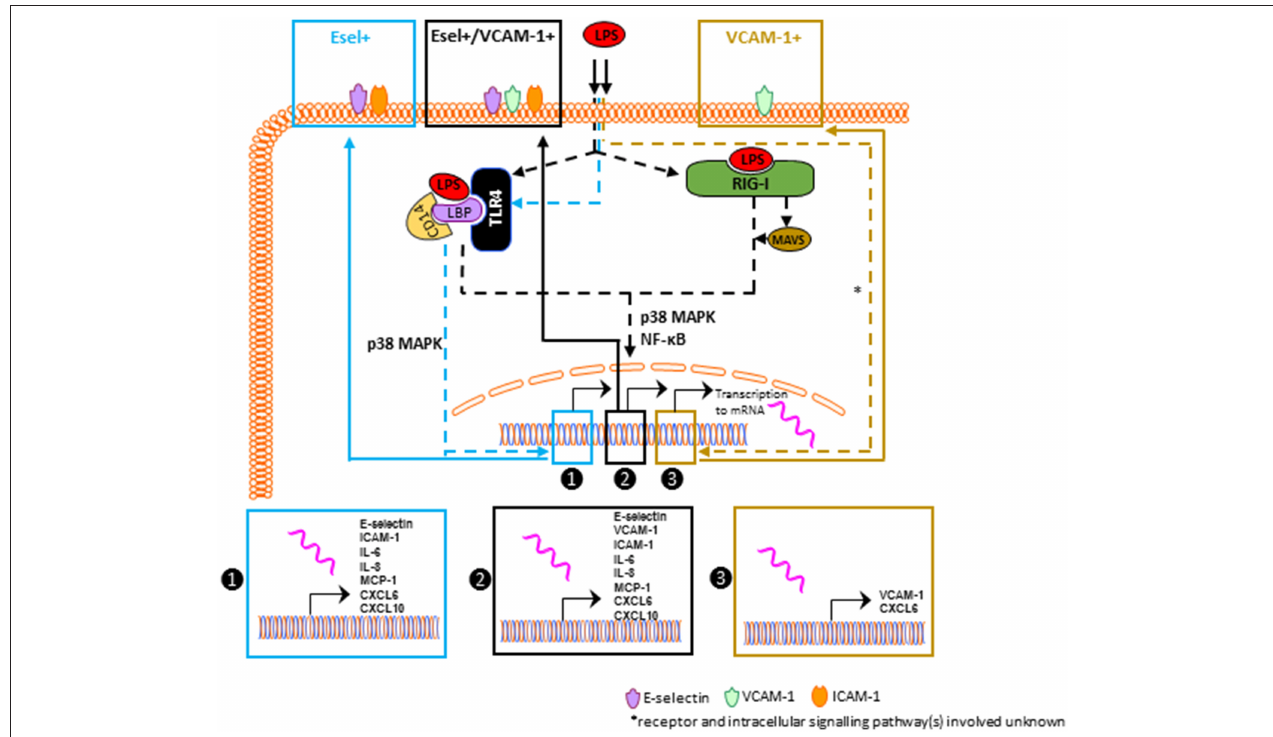
FIGURE 7 | Proposed cellular regulatory mechanisms that control the formation of LPS-mediated EC subpopulations. Dashed lines represent pathways involved in transcriptional control of pro-inflammatory molecules, and solid lines represent pro-inflammatory proteins on EC. The blue, black, and brown lines represent intracellular signaling pathways that determine E-sel + , E-sel + /VCAM-1 + , and VCAM-1 + subpopulation formation.